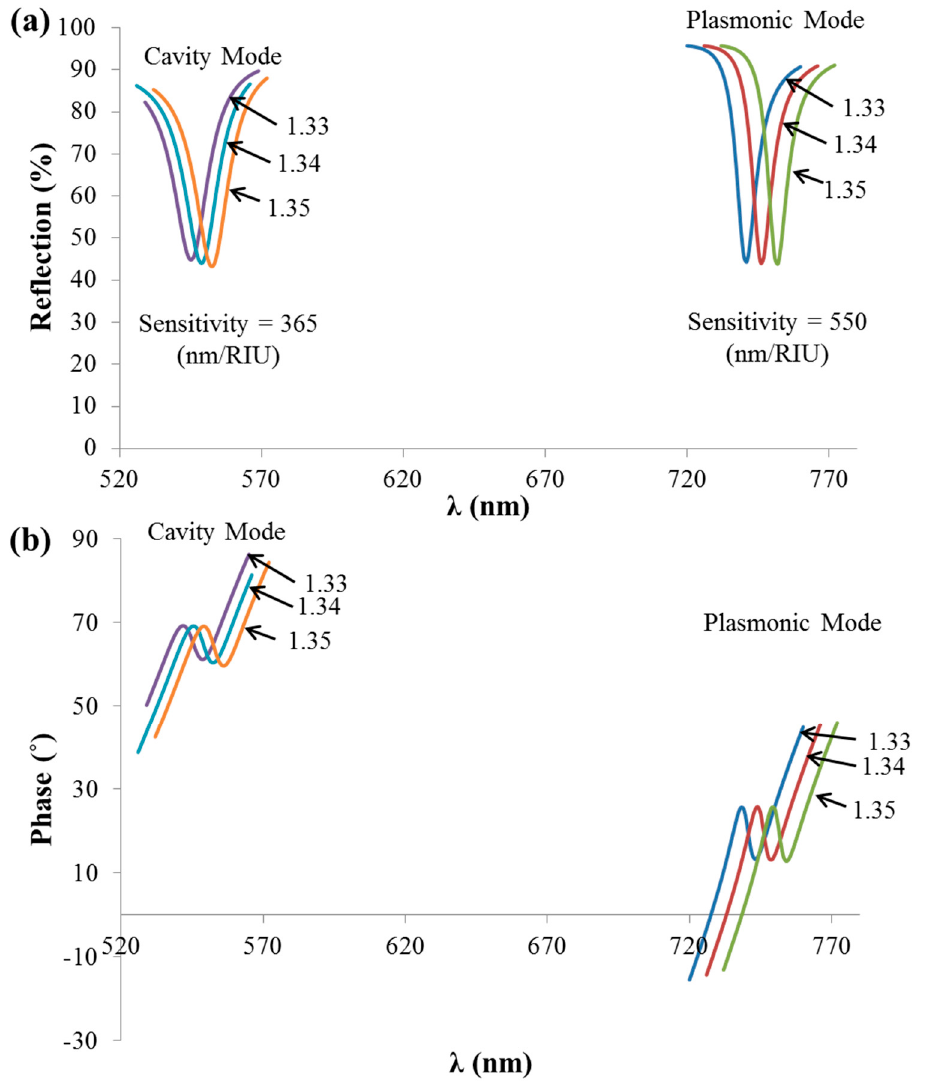
Figure 11. ( a ) Reflection spectra from the thick reflecting grating geometry at different analyte RIs. ( b ) Phase response at the same RIs as in Figure 11a. TM-polarized light under normal incidence was used in the simulations of the Ag grating FF = 0.85. Si was used for the substrate. For the CM calculations, Λ = 300 nm, h = 600 nm were used, while for the SPM calculations, Λ = 1050 nm, h = 20 nm were used.